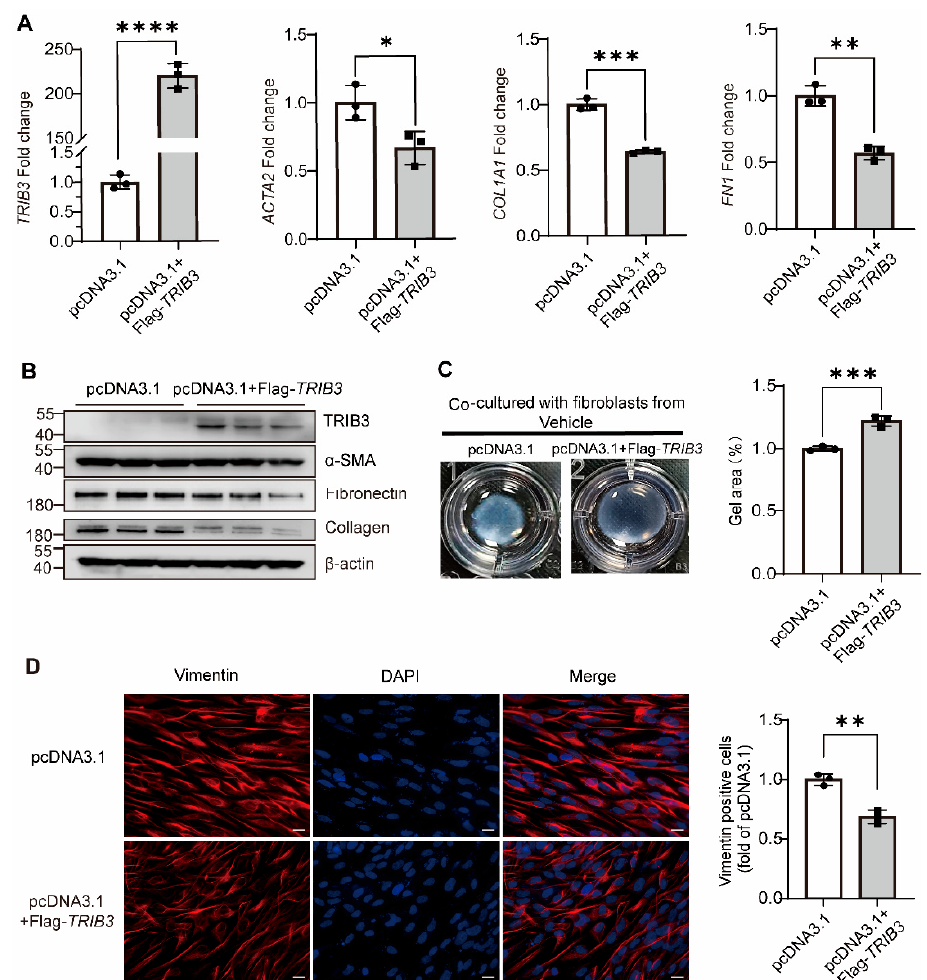
Figure 4. TRIB3 inhibits lung fibroblast activation. ( A ) Gene expression analysis by qPCR demon- strates a significant decrease in ACTA2 , COL1A1 , and FN1 transcript levels in TRIB3 -overexpressing normal lung fibroblasts. GAPDH was used as an internal control. The results were analyzed by the unpaired Student’s t -test for comparisons between two groups with normal distribution. Data are presented as mean ± SD. * p < 0.05, ** p < 0.01, *** p < 0.001, and **** p < 0.0001. ( B ) Western blot analysis showed α SMA, collagen I, and fibronectin elevation in TRIB3 -overexpressed lung fibroblasts (N = 3 independent experiments). β -actin was used as an internal control. ( C ) The activation of fibroblasts was examined based on fibroblast contraction in 3D collagen matrices (N = 3 independent experiments). We used ImageJ software to measure the area of gels. The results were analyzed by the unpaired Student’s t -test for comparisons between two groups with normal distribution. Data are presented as mean ± SD. *** p < 0.001. ( D ) MRC5 cells were subjected to immunofluorescence with a vimentin antibody. Scale bars, 20 µ m. ImageJ software was used to quantify the fluorescence intensity. The results were analyzed by the unpaired Student’s t -test for comparisons between two groups with normal distribution. Data are presented as mean ± SD. ** p <